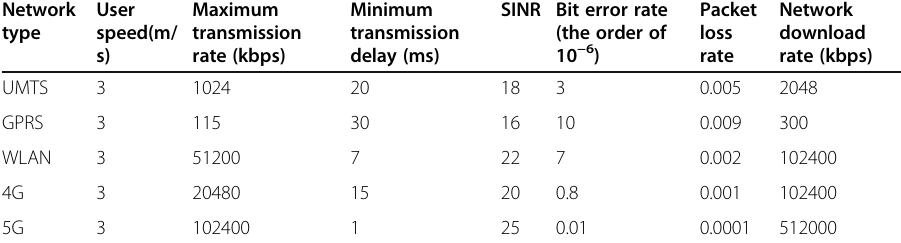
Table 1. Experience value of training parameters in heterogeneous integrated network Network